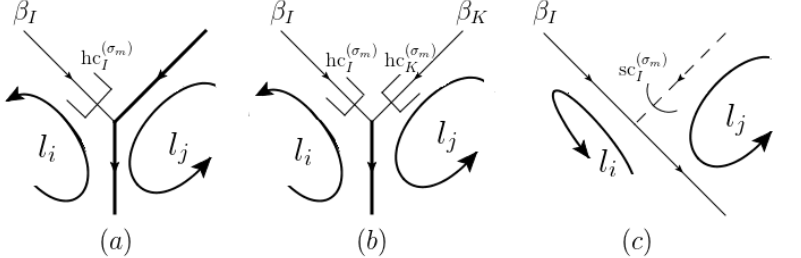
Figure 40. The three cases where the loop momenta l (cid:22) approximation operator t (cid:27)